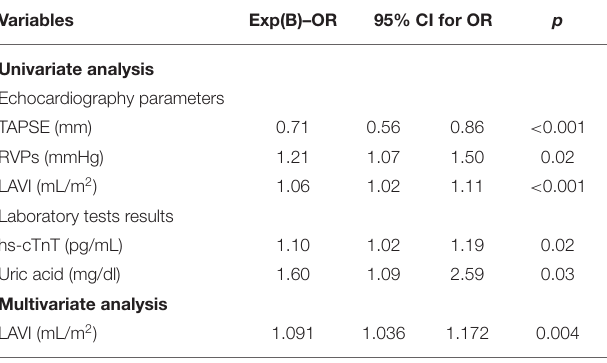
TABLE 8 | Univariate and multivariate analyses of association of patient characteristics with the occurrence of AF after PS matching. Variables Univariate